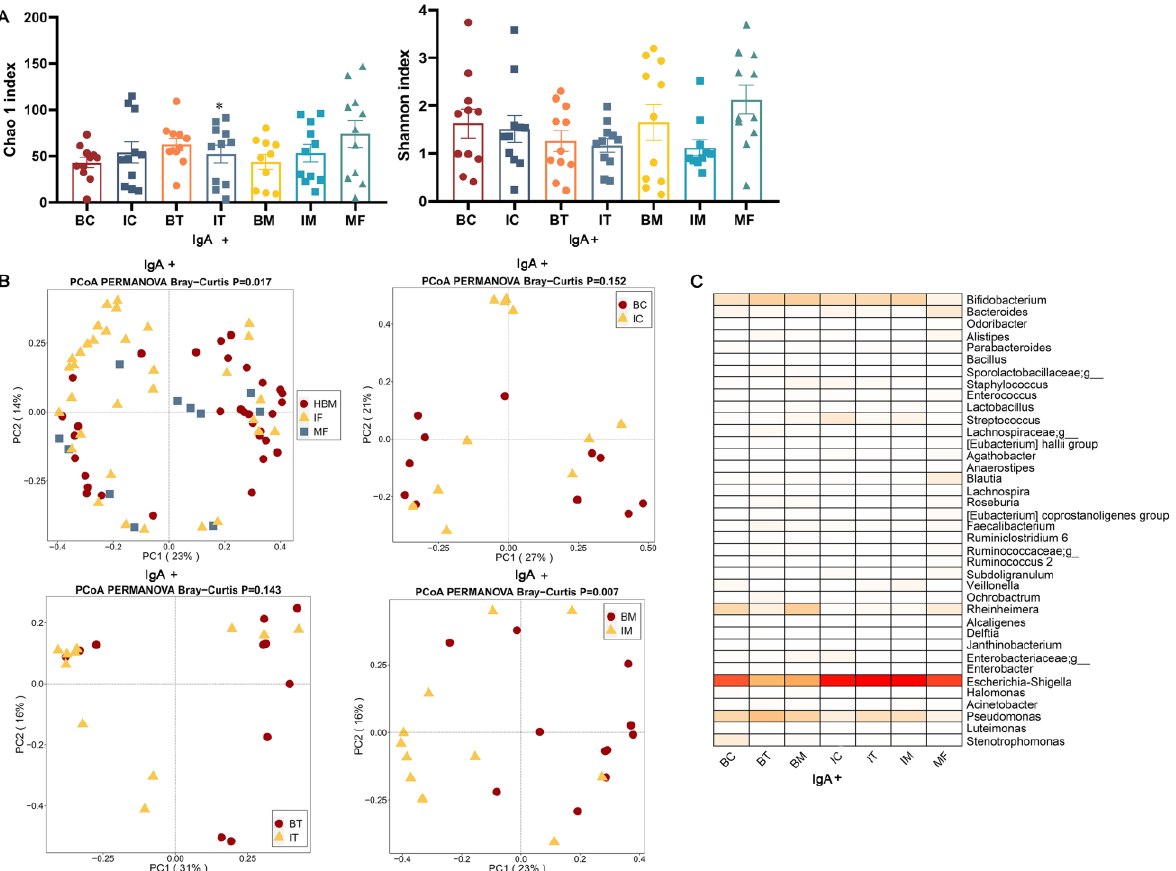
Figure 2. Diversity and composition of sIgA-coated bacteria in HBM, infant feces, and maternal feces. ( A ) Alpha diversity feces. ( B ) Beta diversity. ( C ) Heatmap of the composition of sIgA-coated bacteria in HBM, infant feces, and maternal feces. Genera of relative abundance > 0.01% and calculated with log10 are shown. The darker color corresponds higher relative abundance. The Bray–Curtis distance was utilized to calculate the difference between samples using PERMANOVA. *, p < 0.05; three stages of infant feces compared to corresponding HBM. IgA+ means IgA-coated bacteria .